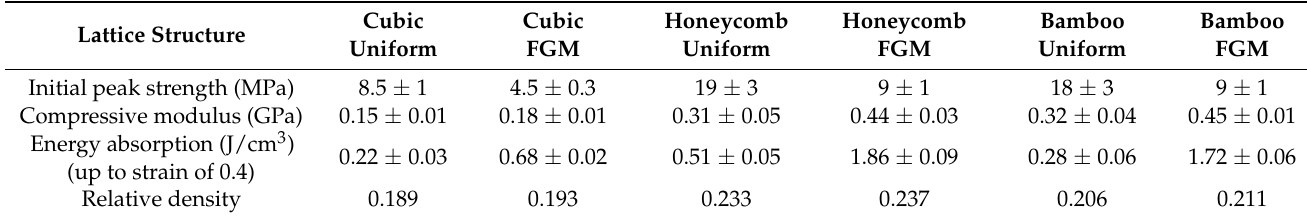
Table 2. Compressive properties of the PEEK specimens with six types of lattice structures.